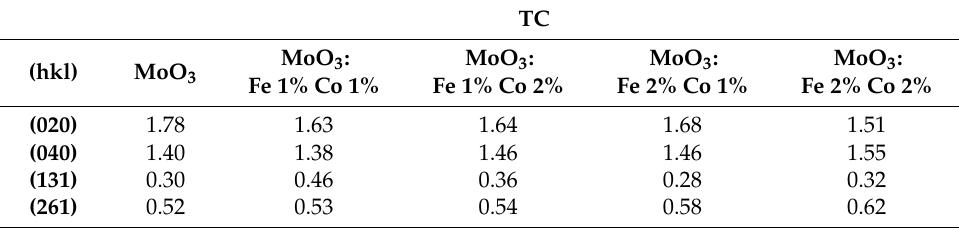
Table 2. The texture coefficient TC ( hkl ) calculated for the Fe-Co doped MoO 3 thin